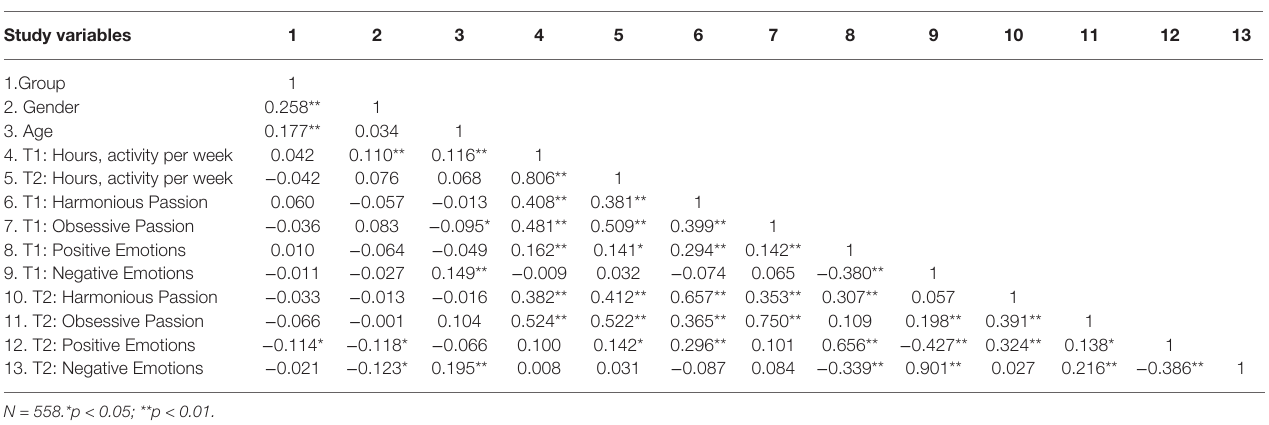
TABLE 2 | Bivariate correlations for study variables.